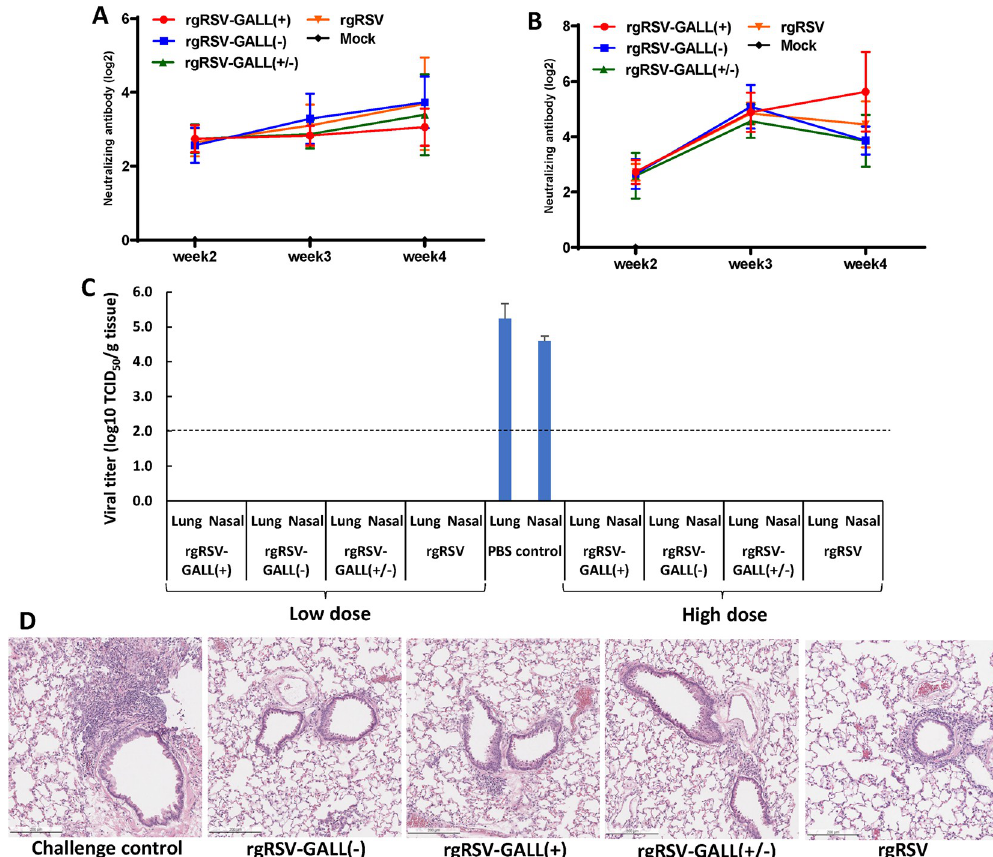
Fig 11. Immunogenicity of m 6 A-deficient rgRSVs in cotton rats. Four-week-old SPF cotton rats were inoculated intranasally with 2.0 × 10 3 or 2.0 × 10 5 TCID 50 of each rgRSV. Blood samples were collected from each rat weekly by retro- orbital bleeding. The RSV-neutralizing antibody titer was determined using a plaque reduction assay (A and B). At week 4 post-immunization, cotton rats were challenged with 2.0 × 10 5 TCID 50 rgRSV. At day 4 post-challenge, the cotton rats were sacrificed, and lungs and nasal turbinate were collected for virus titration by TCID 50 assay (C). Antibody titers and viral titers are the geometric mean titer (GMT) of 5 animals ± standard deviation. The detection limit for virus in tissue is 2.0 log TCID 50 /g tissue. Error bars represent SD from n = 5 mice. � P < 0.5, �� P < 0.01, ��� P < 0.001, ���� P < 0.0001. (D), Lung histology from RSV-infected cotton rats. Hematoxylin-eosin (HE) staining of lung tissue was shown. Histological images were taken under light microscopy. Micrographs with × 20 magnification (scale bar of 500 μ m) are